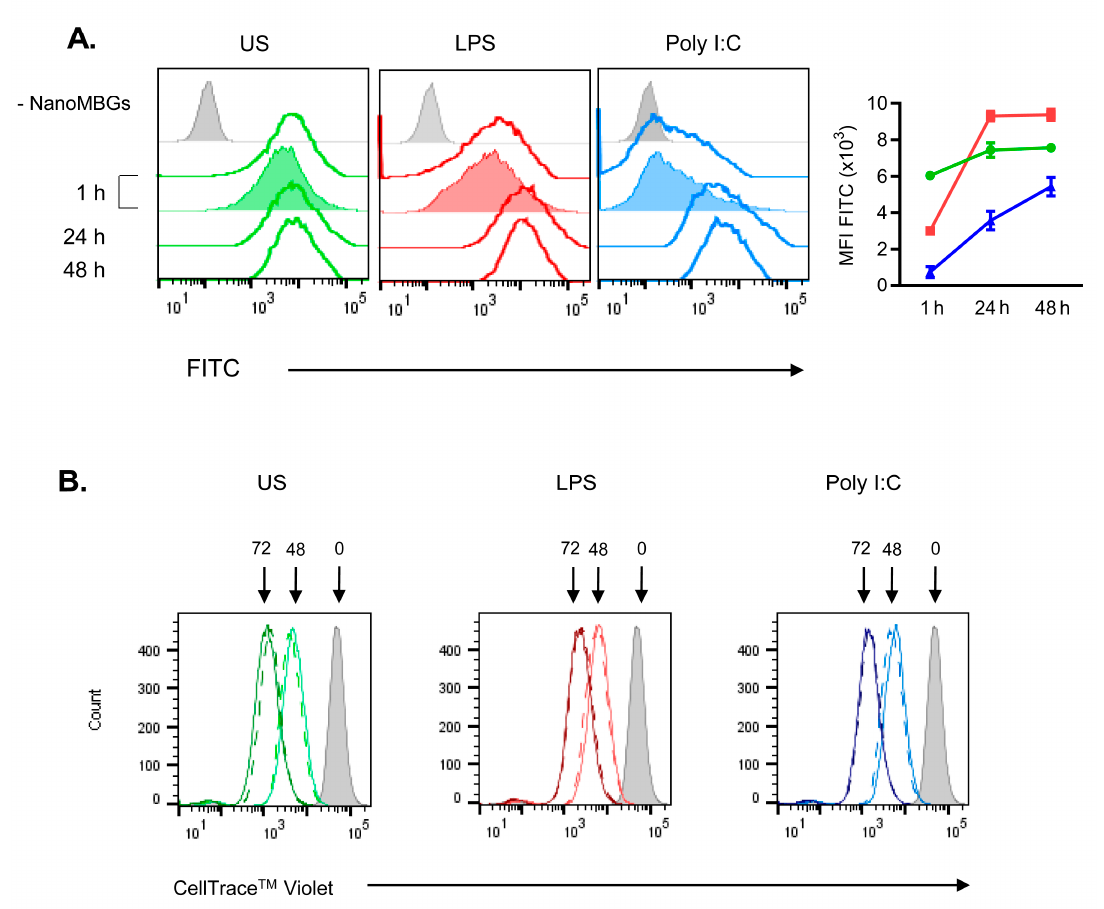
Figure 7. Incorporation of NanoMBGs into DC2.4 cells and e ff ect on proliferation. ( A ) Time-course of the incorporation of FITC-NanoMBGs in DC2.4 cells cultured in the presence of di ff erent stimuli which promote dendritic cell maturation. Overlay histograms are representative of three experiments. DC2.4 cells were unstimulated (US, green) or LPS- (red) or Poly I:C (blue)-stimulated during 1, 24 or 48 h. In 1 h experiments, cells incubated with nanospheres and untreated (solid lines) or trypan blue-treated (green, red or blue filled histograms) are shown. Overlays show 24 h and 48 h results. Graph shows cytometry analysis (median of fluorescence intensity, MFI). ( B ) Overlay histograms showing DC2.4 cells proliferation measured by CellTrace TM Violet during 48 and 72 h with LPS or Poly I:C or without (US) stimuli and in the presence (solid line) or absence (dashed line) of NanoMBGs. Data from one representative experiment out of three, each with triplicates, are shown.